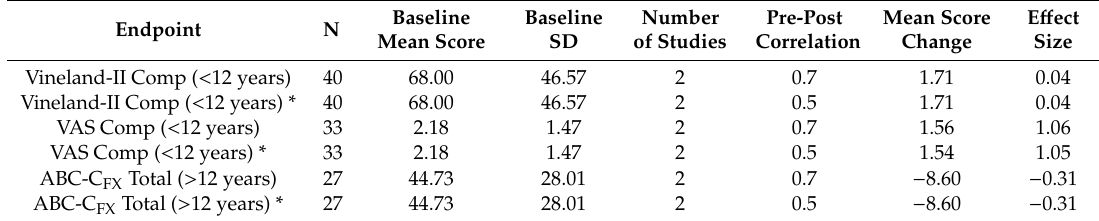
Table 6. Failed clinical trials in FXS: placebo-treated e ff ect size of improved outcome